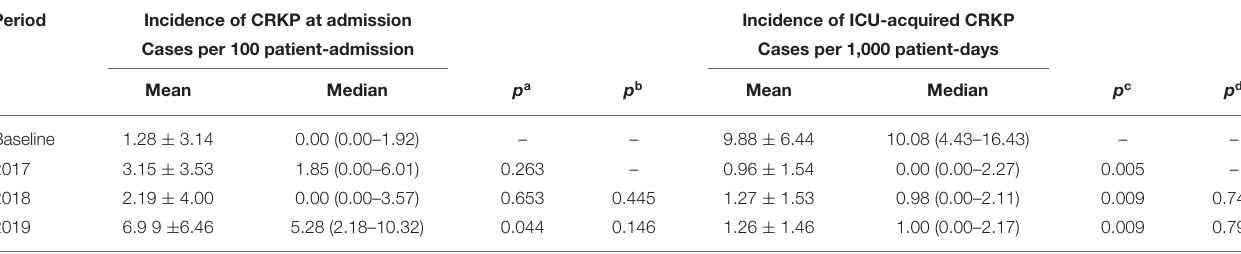
TABLE 4 | Incidence of ICU-acquired CRKP and CRKP at admission during the baseline and intervention periods. Period Incidence of CRKP at admission Incidence of ICU-acquired CRKP Cases per 100 patient-admission Cases per 1,000